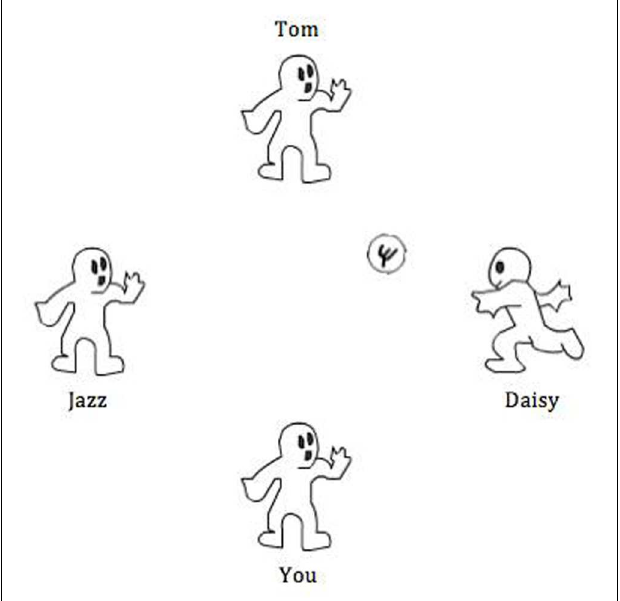
FIGURE 1 | An example of the screen viewed by participants during